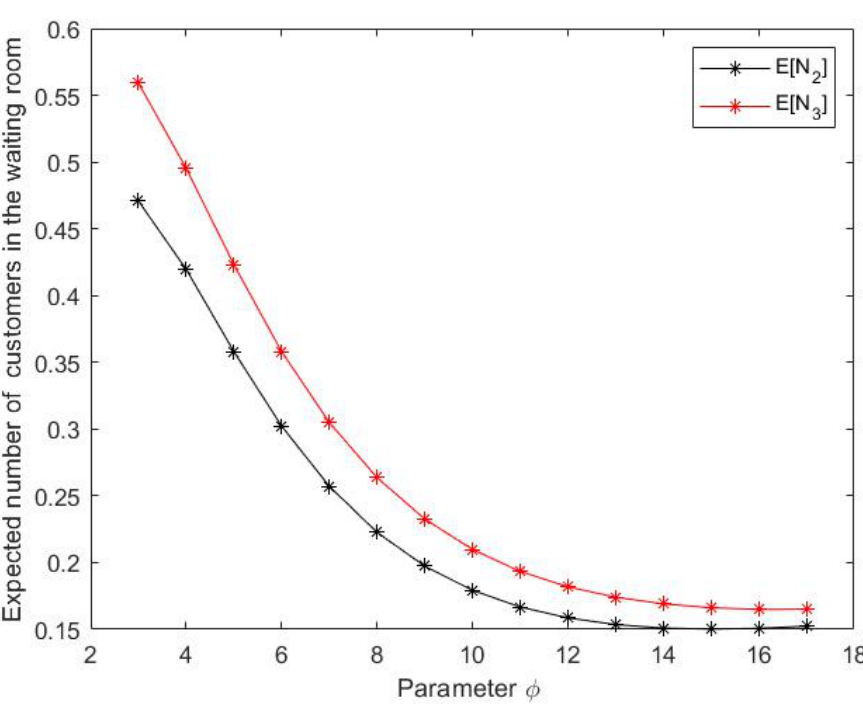
Figure 3. Effect of φ on expected number of customers in the waiting room.